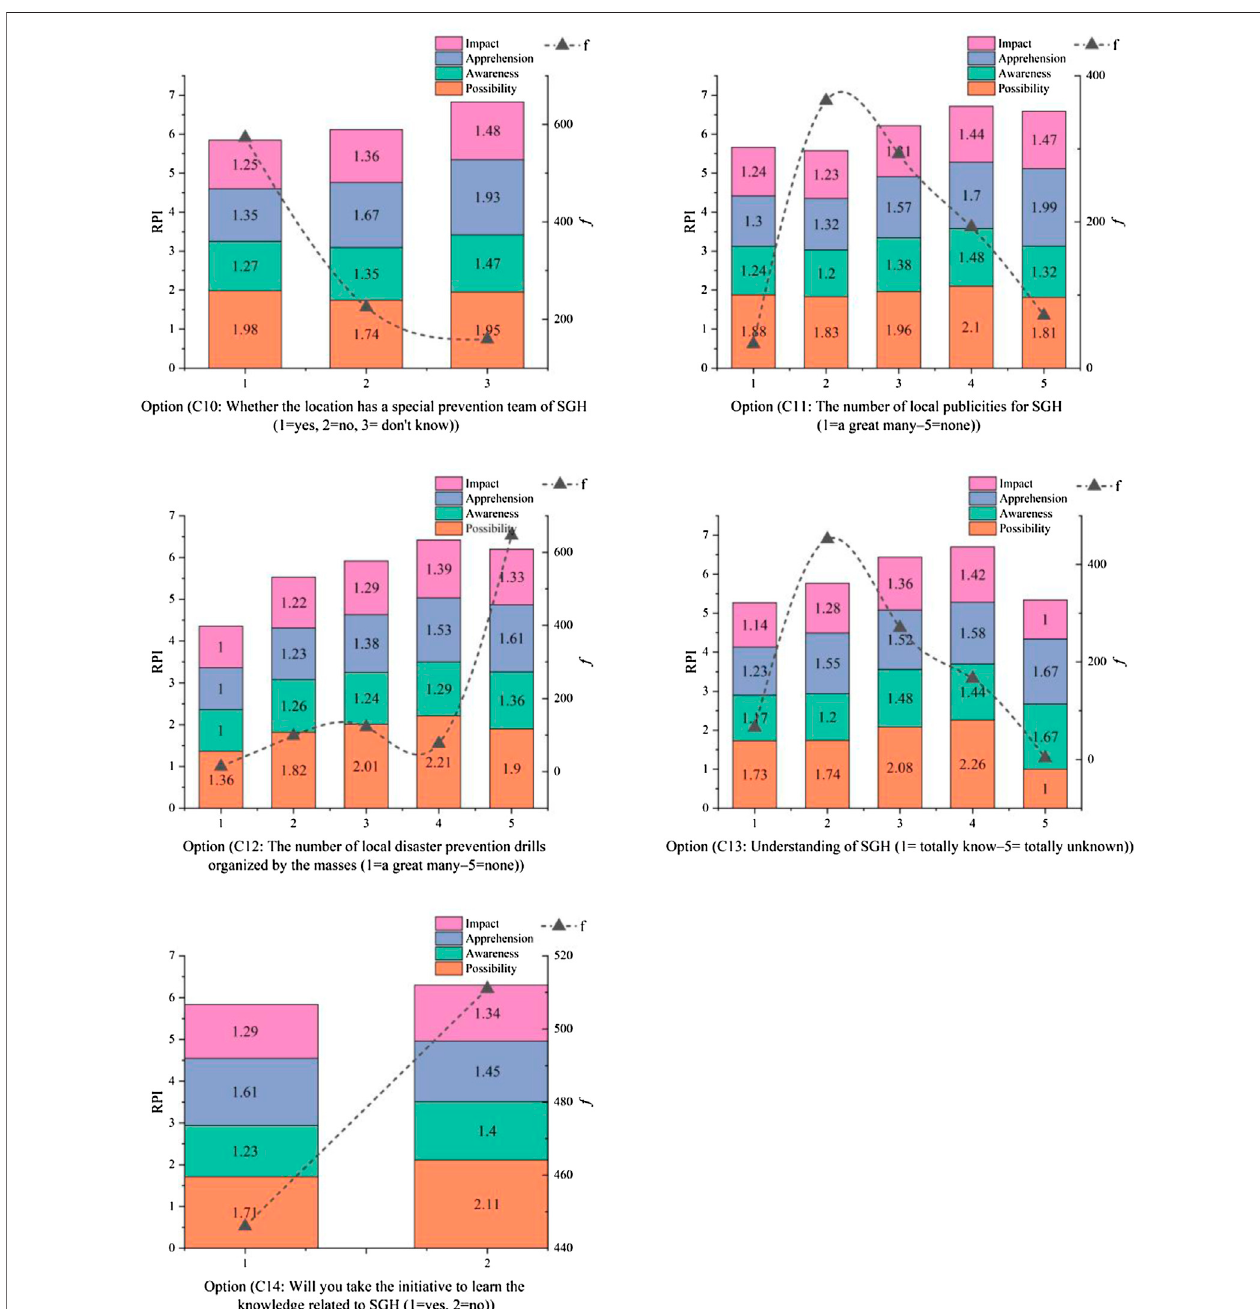
FIGURE 7 | The impact of risk communication on risk